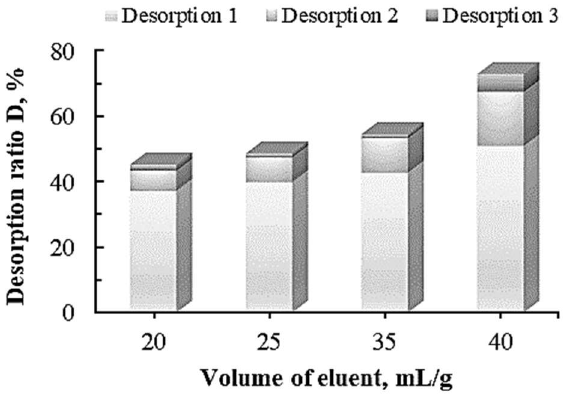
Figure 13. Desorption ratio of sinigrin after several desorption cycles using 1.0 NaCl and various liquid-solid ratios at 30 °C.